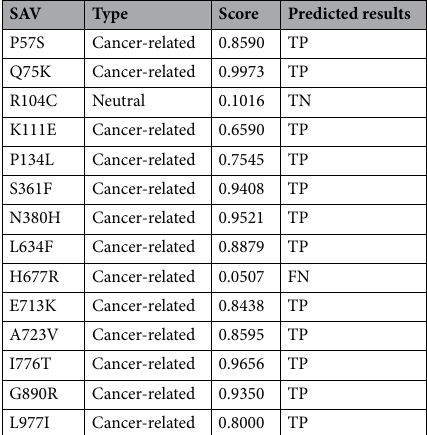
Table 7. Predicted results for the 14 SAVs of the